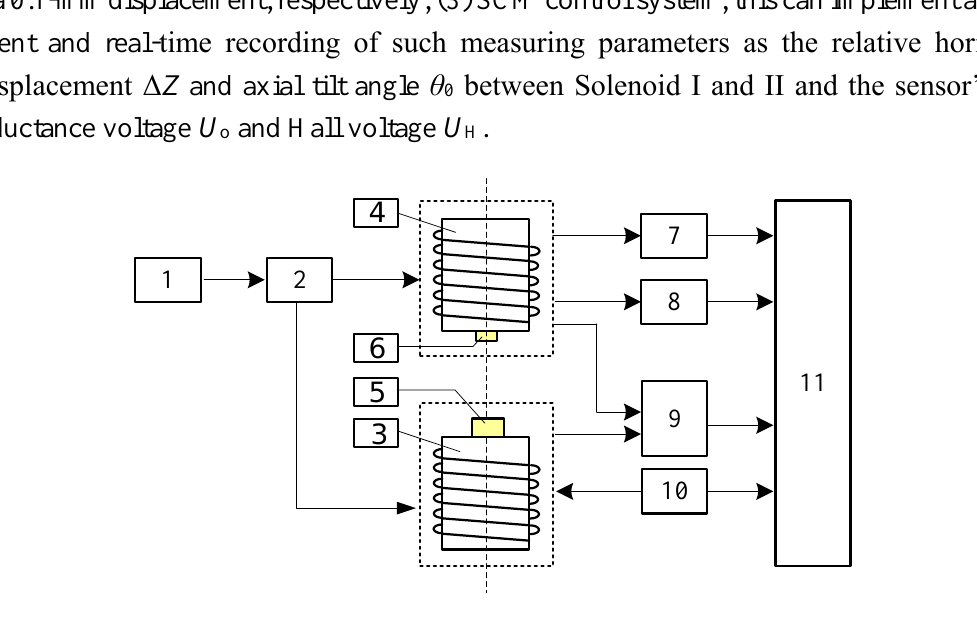
Figure 5. Schematic diagram of the experimental setup. 1, 4-axial driving controller; 2, 4-axial driving unit; 3, Solenoid I; 4, Solenoid II; 5, permanent magnet; 6, Hall sensor; 7, mutual inductance voltage measuring circuit; 8, Hall voltage measuring circuit; 9, tilt measuring circuit; 10, sine voltage generating circuit; 11, single-chip microcomputer (SCM)